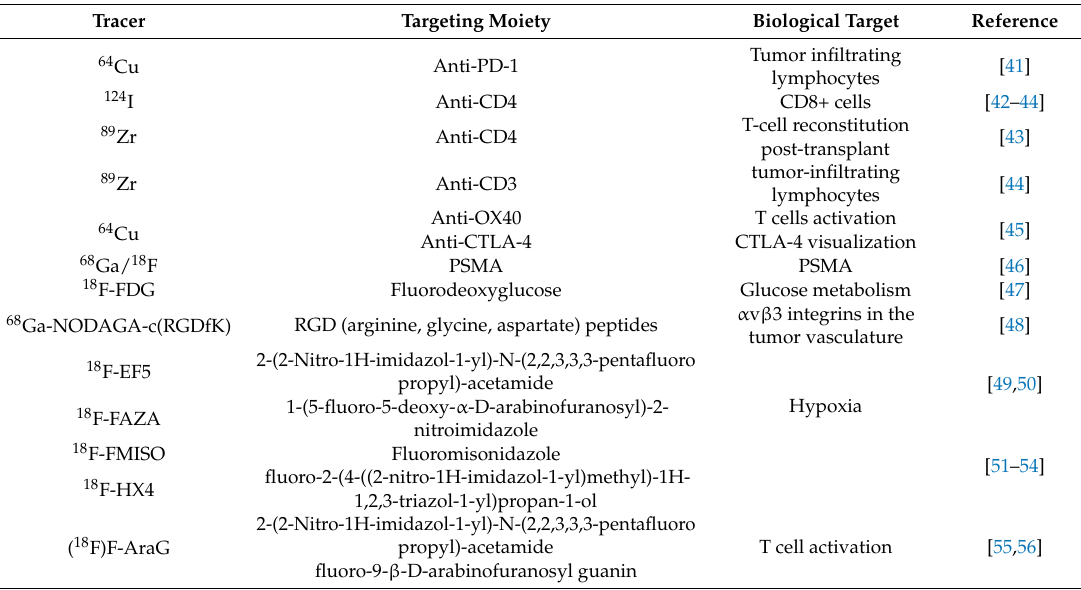
Table 2. Summary of tracers used in preclinical studies and their biological